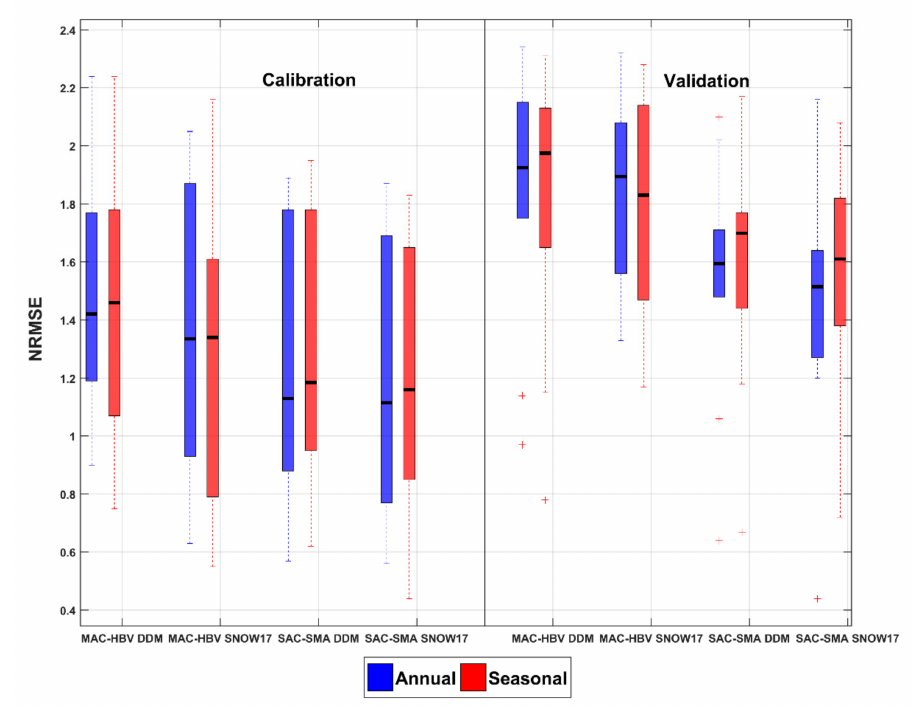
Figure 7. NRMSE statistics for MAC-HBV-DDM, MAC-HBV-SNOW-17, SAC-SMA-DDM, SAC-SMA- SNOW-17 model combinations for annual and seasonal models of LGRB. NRMSE is computed for spring season flows above 75 percentile. See Figure 5 for box plot description.